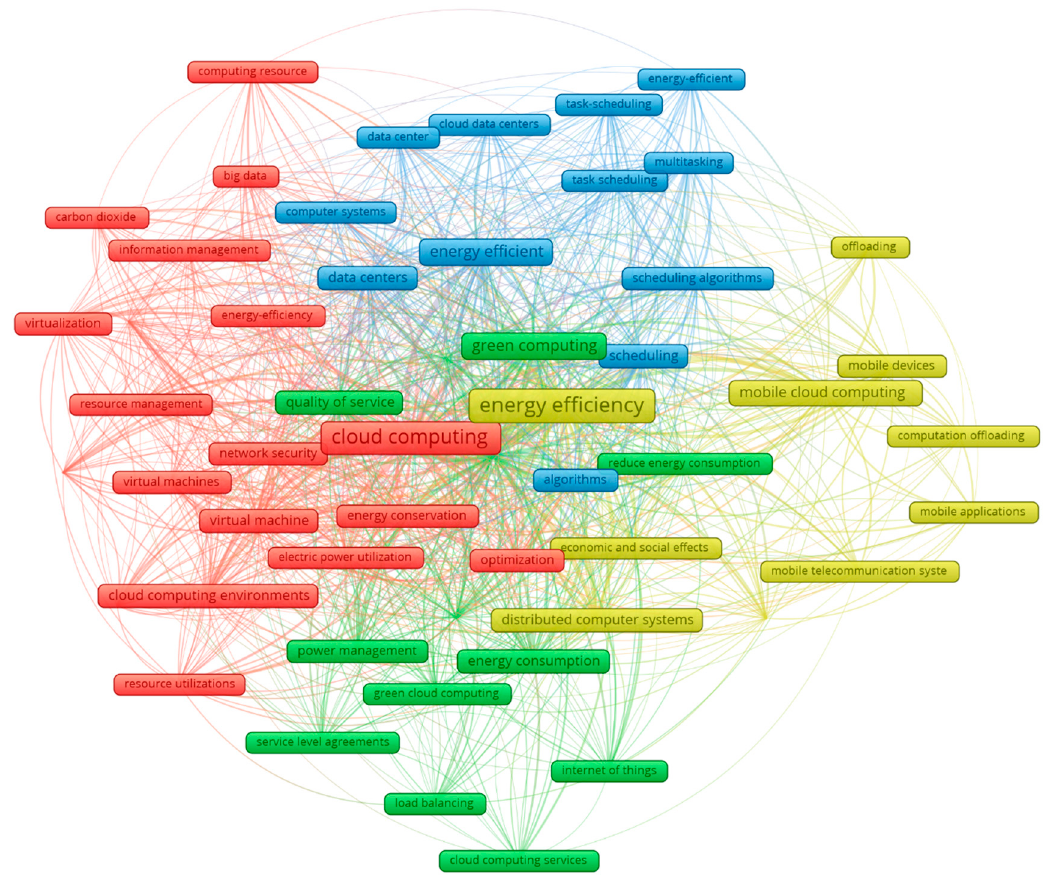
Figure 4. Thematic clusters in research on cloud computing energy efficiency. Source: authors’ own study. Data sourced from Scopus, analyzed with VOSviewer (20 May 2020).